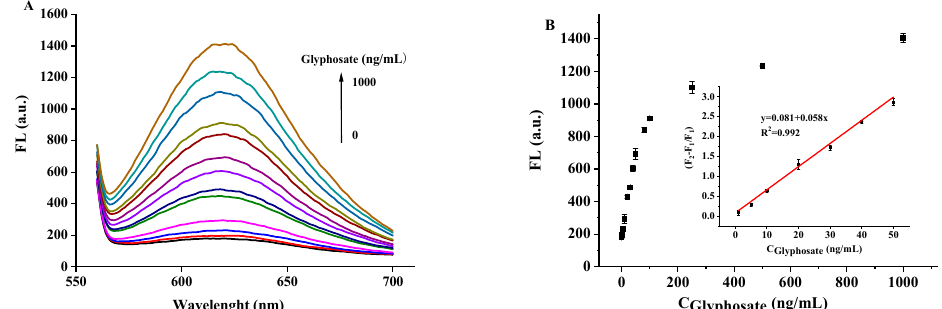
Figure 10. Effects of ( A ) pH and ( B ) different concentrations of Cu 2+ on the recovery efficiency of DNA2-Ag NCs/Cu 2+ /glyphosate. 4.5. Analytical Performance of the Glyphosate Detection As shown in Figure 11, the fluorescence recovery, (F 2 − F 1 )/F 1 , gradually increased with the increased concentration of glyphosate in the range of 1.0 ng/mL~400 ng/mL, and a linear equation, y = 0.058x + 0.081 (R 2 = 0.992), was obtained in the range of 1–70 ng/mL. The LOD was calculated to be 0.2 ng/mL based on 3 σ /s ( σ is the standard deviation of the blank value and s is the slope of the equation). Compared with some other typical fluorescence methods for the detection of